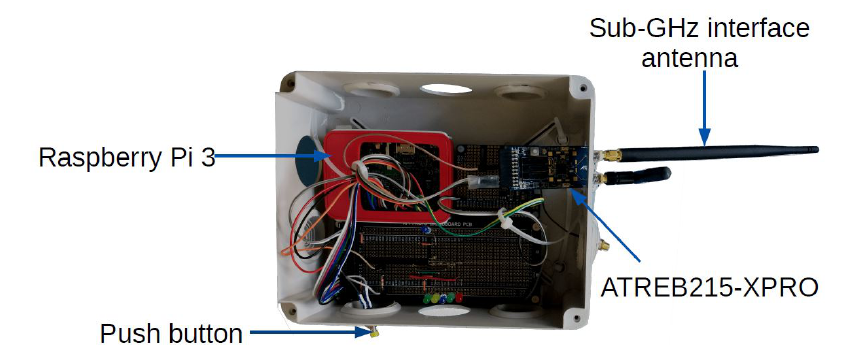
Figure 1. Node used in the range test measurement campaign.